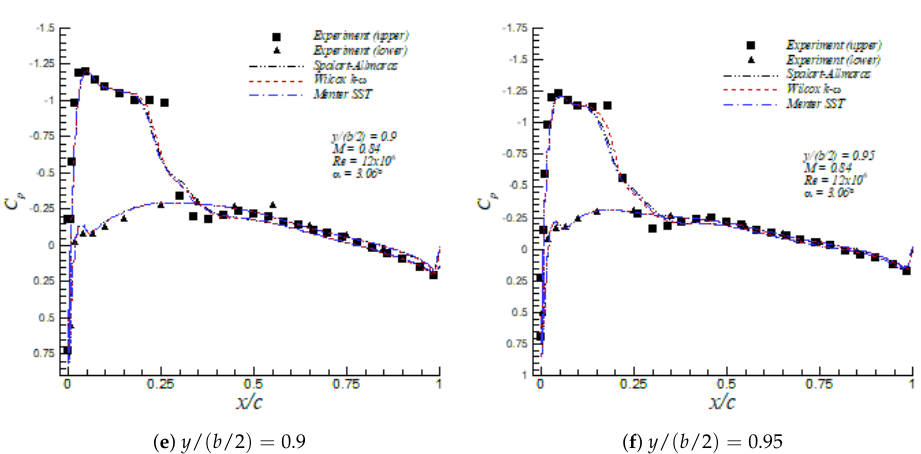
Figure 8. Pressure coefficient distributions in the ONERA M6 wing at α = 3.06 ◦ .